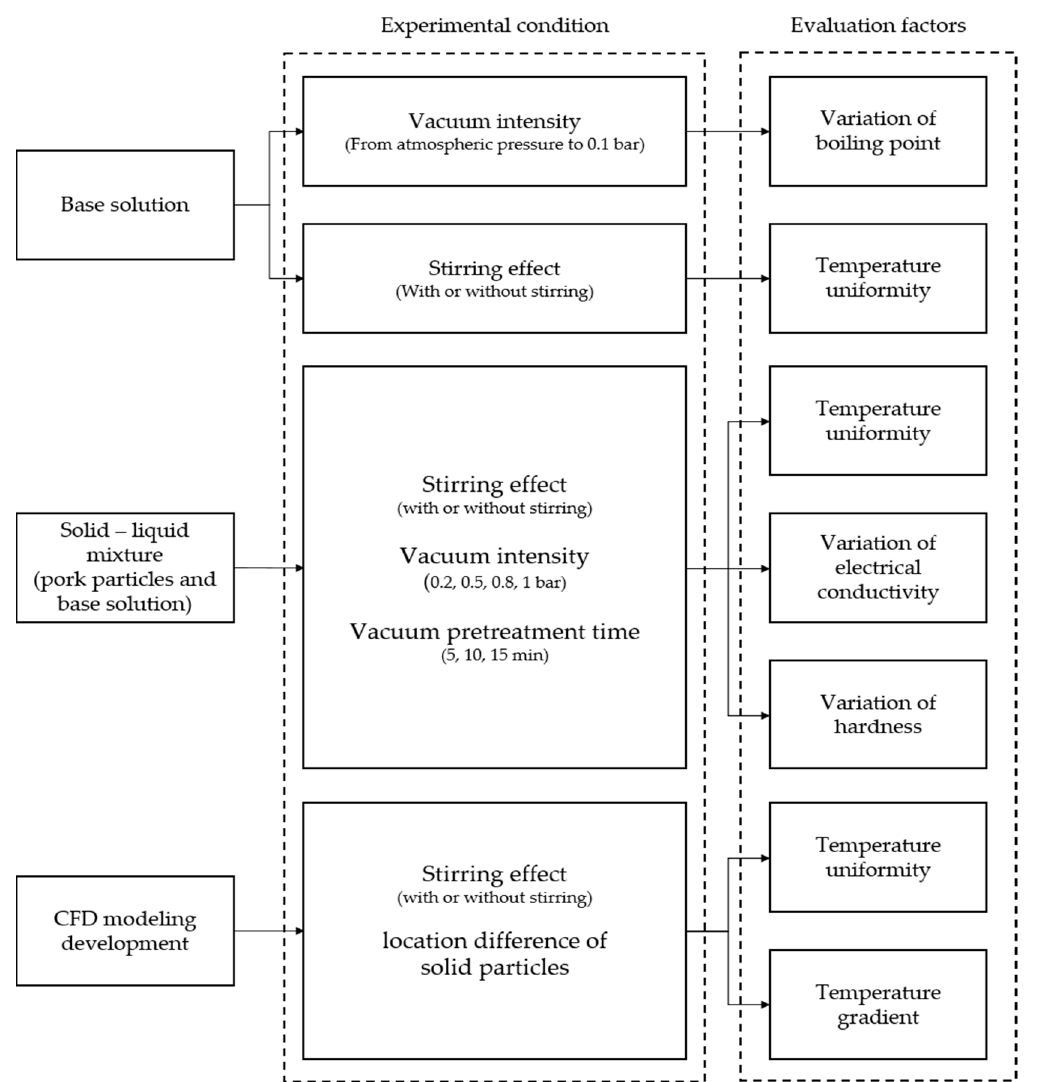
Figure 3. A schematic of overall experimental protocol.